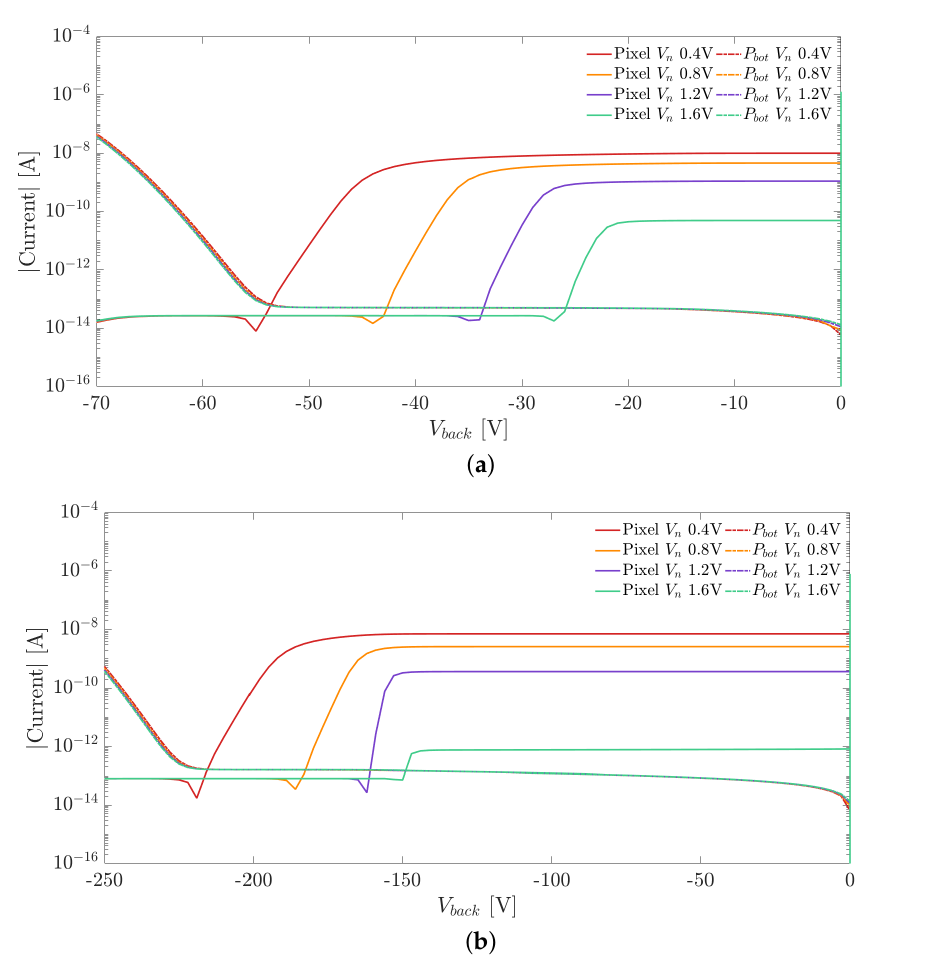
Figure 5. ( a ) Frontside nwell and backside p + implant I–V curves for different values of applied V n in a simulation domain with 25 µ m pixel pitch and substrate thickness of 100 µ m. ( b ) Frontside nwell and backside p + implant I–V curves for different values of applied V n in a simulation domain with 25 µ m pixel pitch and substrate thickness of 300 µ